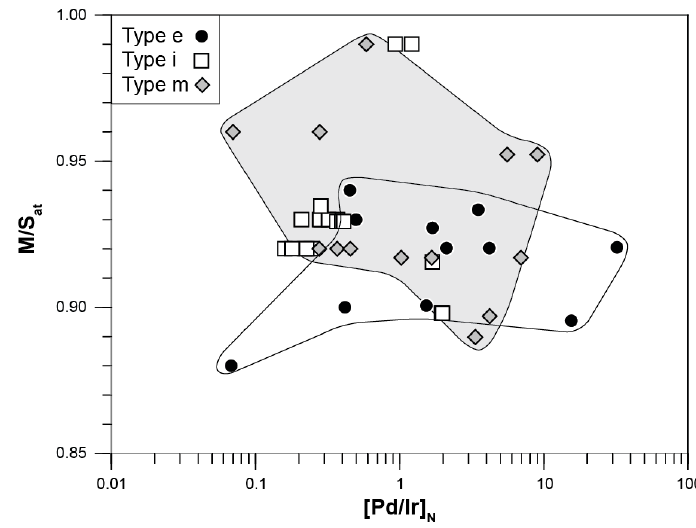
Figure 3. In metal/sulfur ratio (M/S)-[Pd/Ir] N space, the Middle Atlas mss do not show discernible correlation with textural occurrence (type e (enclosed), type i (interstitial), and type m (melt pocket)). Replicate analysis of selected mss grains ( n = 23) document the relatively homogeneous distribution of Fe, Ni, and S contents (RSDs ≤ 3.3 %, ≤ 8.9 %, and ≤ 1.1 %) and typically show highly scattered Cu abundances (RSD ≤ 67.3 %) related to the exsolution phenomena described previously. Pentlandites ( n = 17) are relatively Ni-poor (26.9 to 37.6 wt %), with Ni/(Ni + Fe) at ratios from 0.39 to 0.55. Cobalt concentrations are relatively uniform (~0.1 wt %), whereas Cu varies between 0.1 and 1.3 wt %. The iss analyses ( n = 2) yielded a mineral formula close to the composition of isocubanite, i.e., CuFe 2 S 3 (see Table S3). The relatively high Ni contents of 2.3 and 3.9 wt % may have resulted from contamination by associated mss.